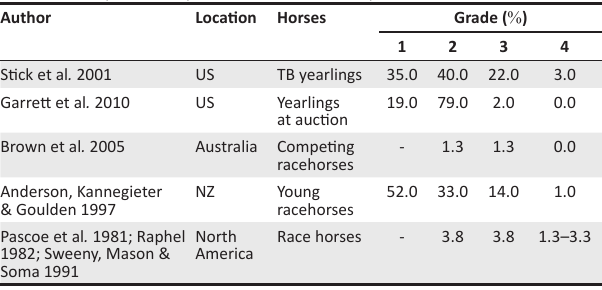
TABLE 1: Comparison of previous similar studies